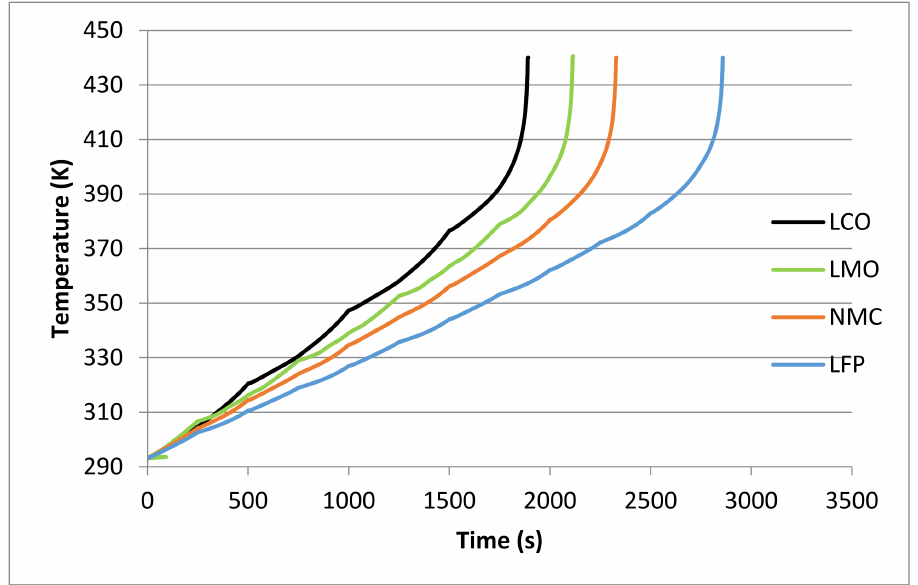
Figure 8. Temperature profiles as a function of time (h = 0 W/m 2 K).